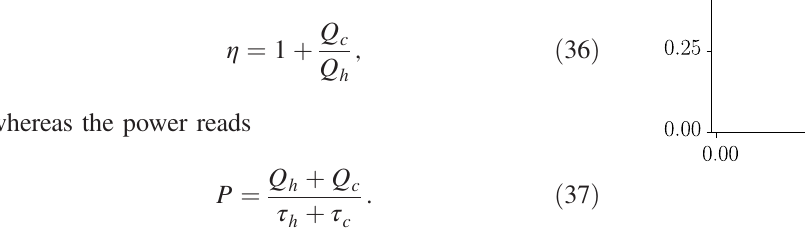
FIG. 3. Efficiency at maximum power. η (cid:4) γ for γ ¼ 1 ; 2 ; 4 ; 8 ; ∞ , with γ ¼ 1 and γ ¼ ∞ corresponding to Curzon-Ahlborn ( η and Carnot efficiency ( η